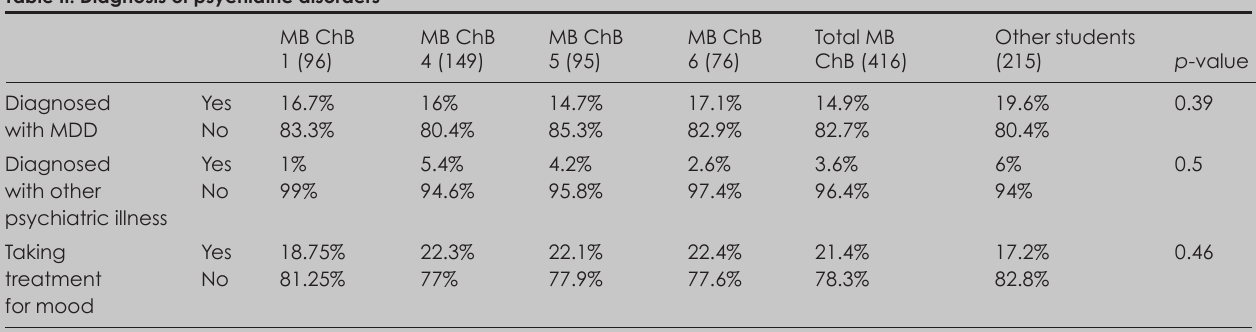
Table II. Diagnosis of psychiatric disorders